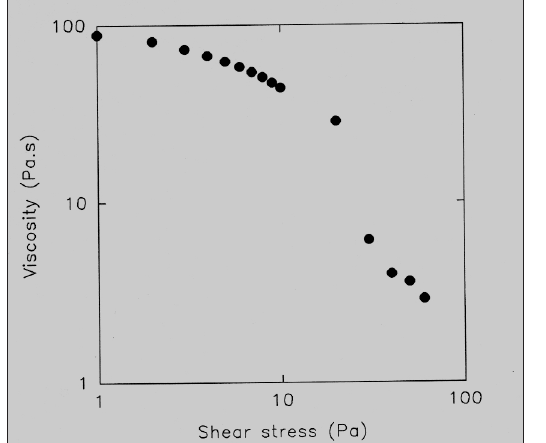
Figure 1 (left): Apparent steady shear viscosity as a function of imposed shear stress for a 1% w/w hydrophobically modified (hydroxypropyl) guar aqueous solution at a rheometer gap of 500 µm. Figure 2 (right): The velocity field in parallel disk geometry in the presence of true wall slip (notations are those of the text).